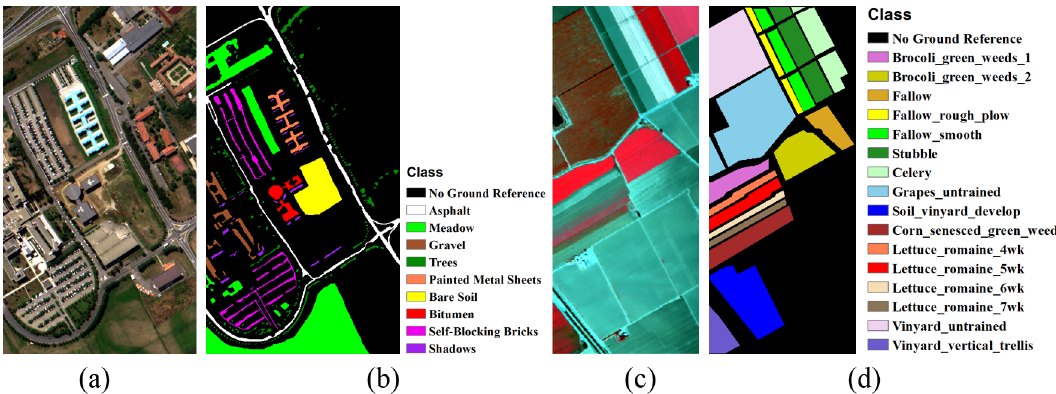
Figure 3. False-color image composites and their corresponding ground-reference data. ( a ) false-color composite of Pavia University image bands (R: band 55, G: band 33, and B: band 13); ( b ) ground-reference data (with class legend) for the Pavia University image; ( c ) false-color composite of Salinas image bands (R: band 57, G: band 27, and G: band 17); ( d ) ground-reference data (with class legend) for the Salinas image. Table 1. Class codes for Pavia University and Salinas images. Pavia University Image Salinas image Class